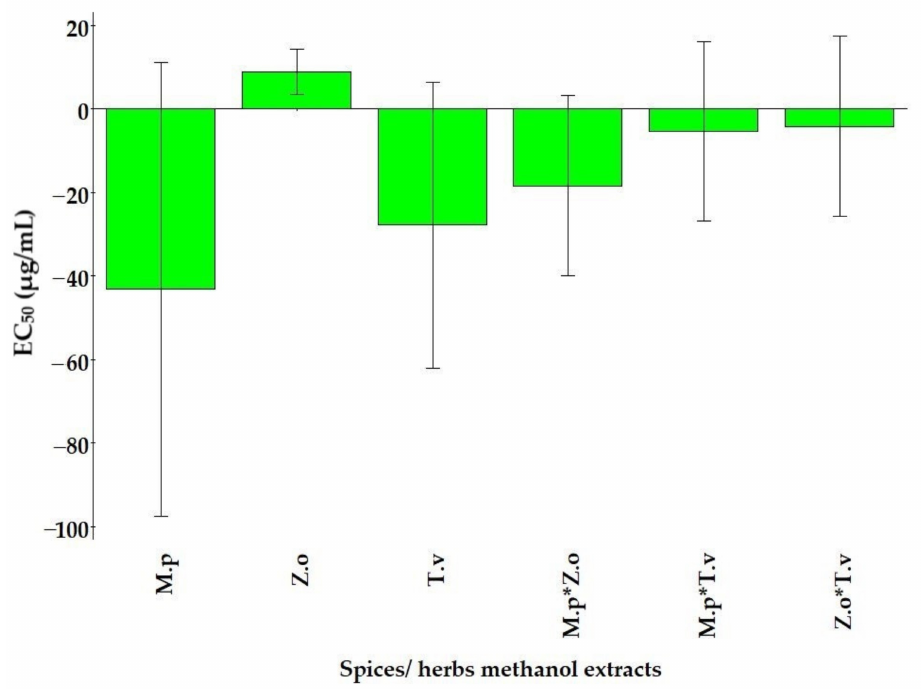
Figure 2. A coefficient plot showing the effects of the three factors M. piperita (M.p) , Z. officinalis (Z.o), and T. vulgaris (T.v) on the antioxidant effect of the mixture